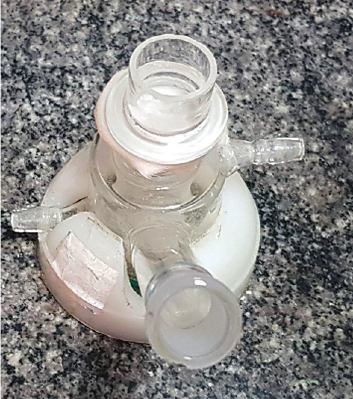
Figure 1: Dialysis